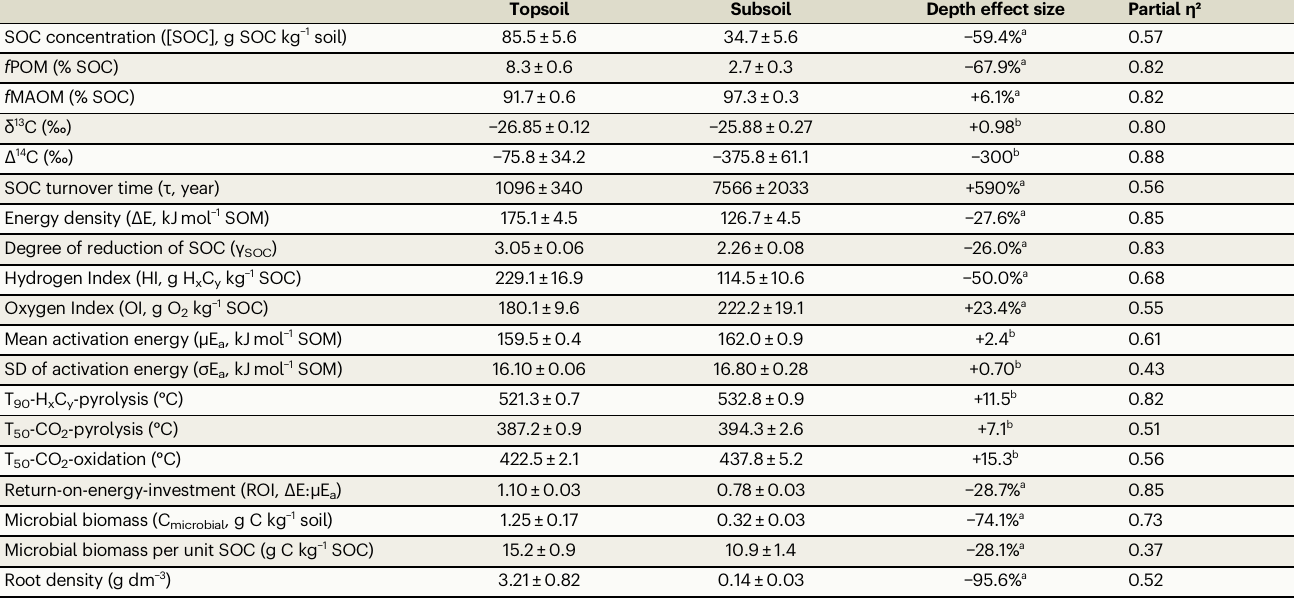
Table 1 | Depth variation in soil organic carbon (SOC) properties averaged across the three soil